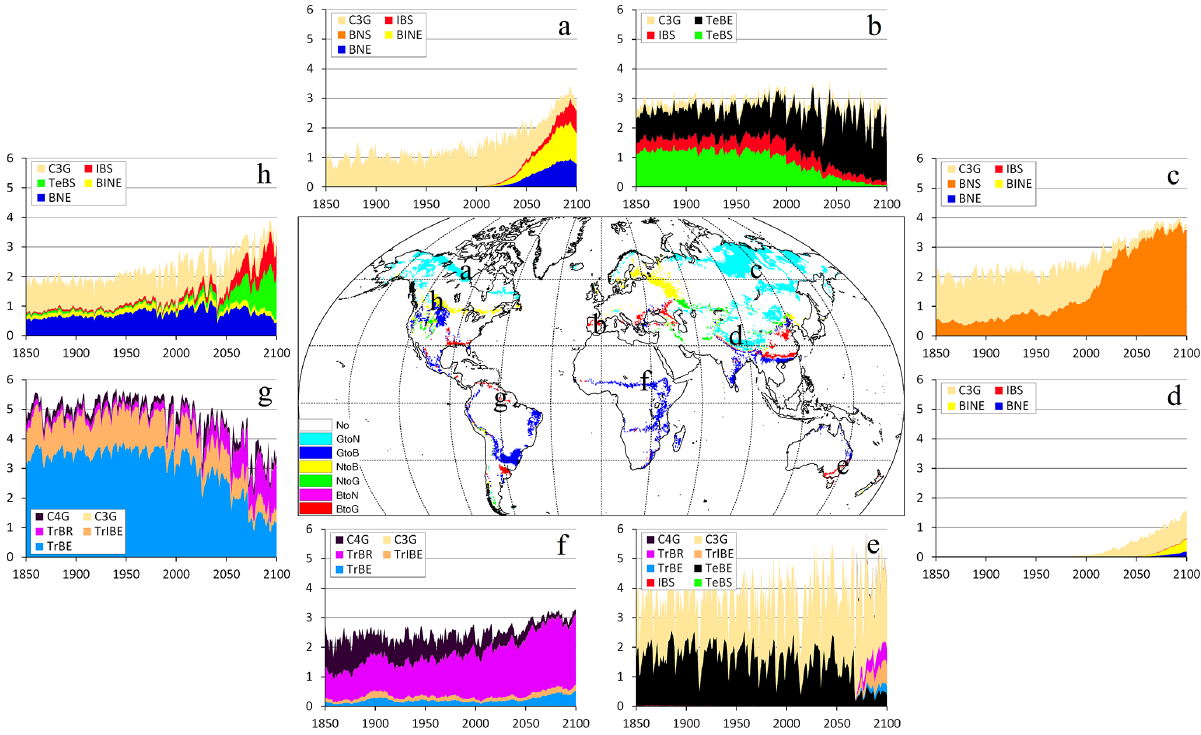
Figure 4. Major biome shift for the C–N version from year 2000–2100, applying the same classification and approach as in Fig. 3. Like in Fig. 3, the global map is accompanied by detailed time-trends for a number of regions identified in Fig.